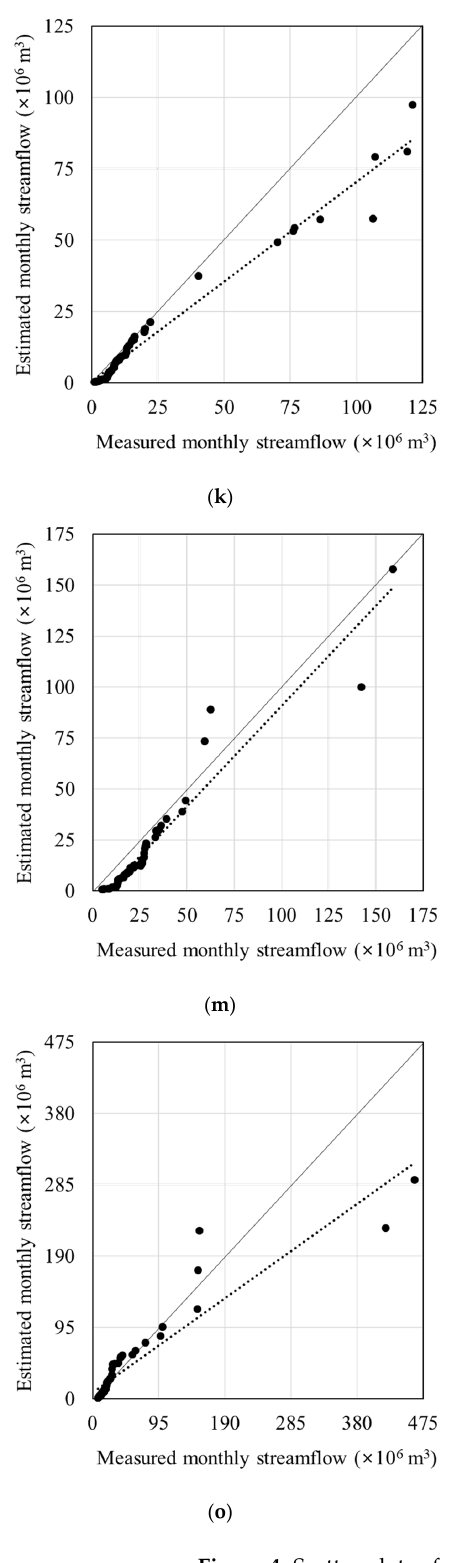
Figure 4. Scatter plots of measured and estimated monthly streamflows during calibration: ( a )